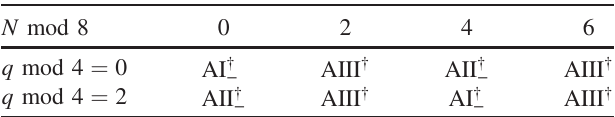
TABLE V. Symmetry classes realized in the chiral two-matrix model H with nHSYK blocks H , H 0 .